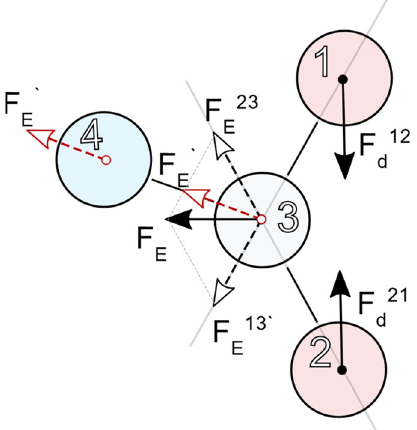
Figure 1. Diagram of the coupling hierarchy in a three-component composite. Particles 1 and 2 interact as magnetic or electrical dipoles and exert forces 𝐹 𝑑12 and 𝐹 𝑑21 on each other. This interaction causes elastic stresses which are transferred by spring links (solid lines) to the polymer particle 3 that, together with the springs attached to it, resembles the matrix. Due to the spring strains, particle 3 experiences elastic forces 𝐹 𝐸13 and 𝐹 𝐸23 , the vector sum of which is transferred as a single force 𝐹 𝐸 via the appropriate spring to particle 4 (the force projection is 𝐹 𝐸′ ) that transfers it outside the presented fragment of the system. We point out that 𝐹 𝐸′ is drawn twice to show its translation from particle 3 to particle 4.